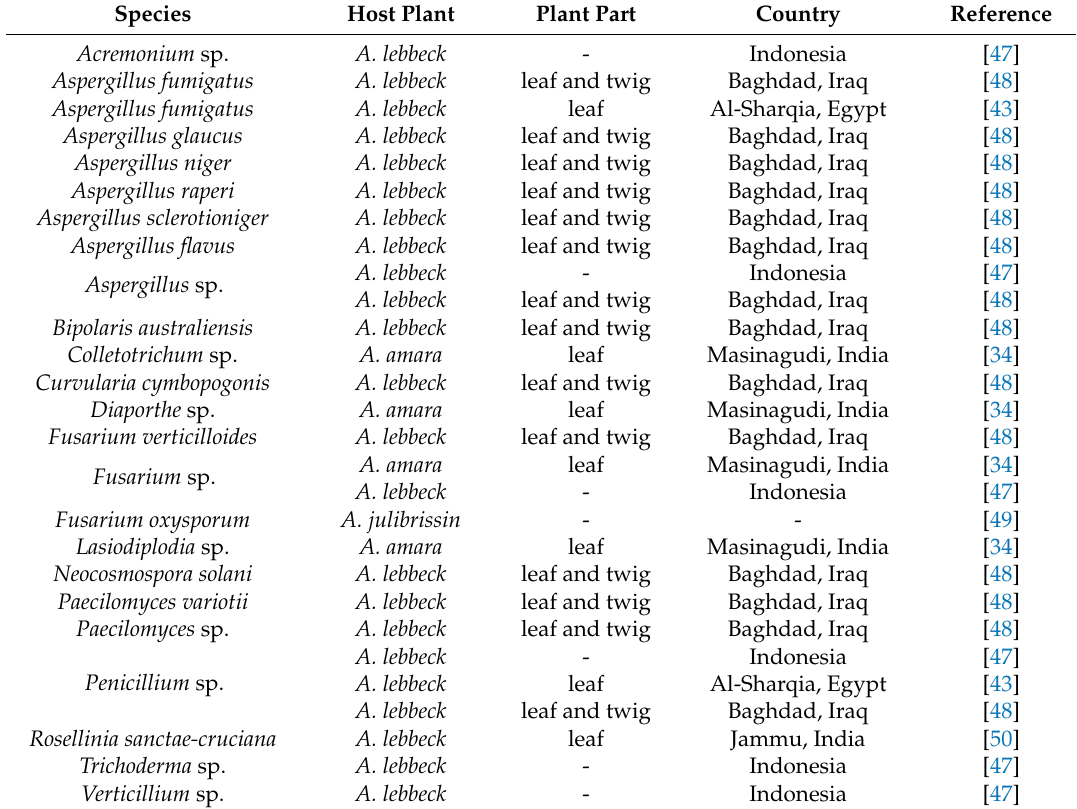
Table 3. Endophytic fungi isolated from Albizia species. Species Host Plant Plant Part